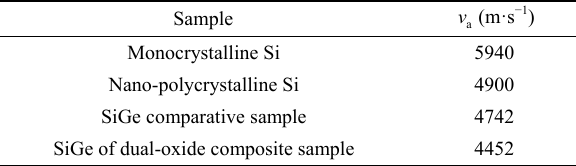
v of the monocrystalline Si, nano-polycrystalline a Si, and SiGe comparative sample and SiGe of dual- oxide composite sample in our work